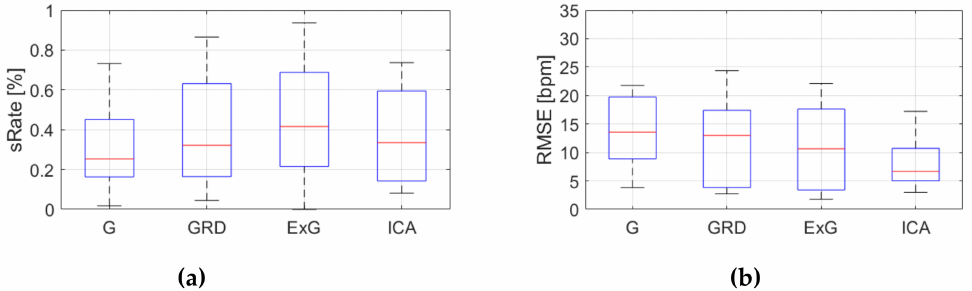
Figure 20. Comparison of signal extraction methods, algorithm No.3 (TIME), part 6: ( a ) box plots for sRate ; ( b ) box plots for RMSE . Blue lines—IQR range, red line—median